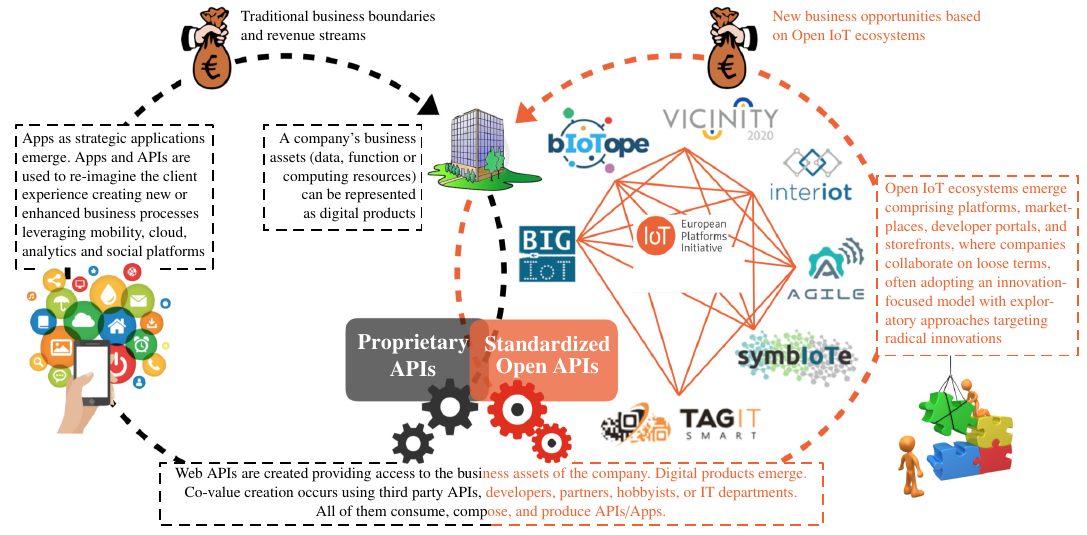
Figure 1. Towards open IoT ecosystems for joint service co-creation and radical innovation practices